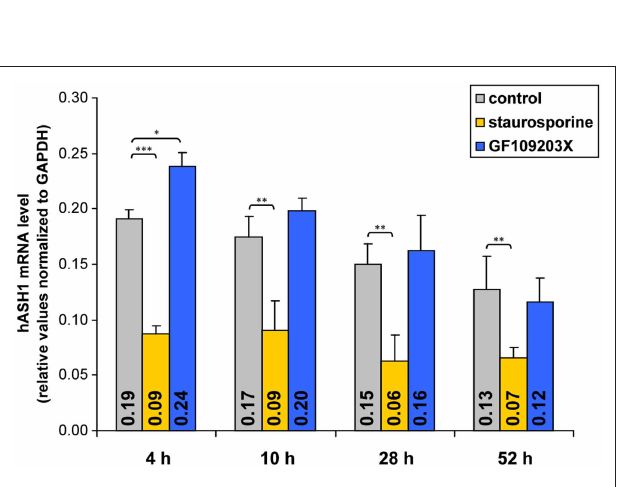
Figure A2 | influence of the PKC inhibitors staurosporine and gF109203X on hASH1 mrNA level. Kelly neuroblastoma cells were treated with the PKC inhibitors staurosporine or GF109203X and hASH1 mRNA levels were estimated by qPCR at different time points. hASH1 mRNA levels were normalized to GAPDH. n = 9; * p < 0.05, ** p < 0.01, *** p < 0.001.